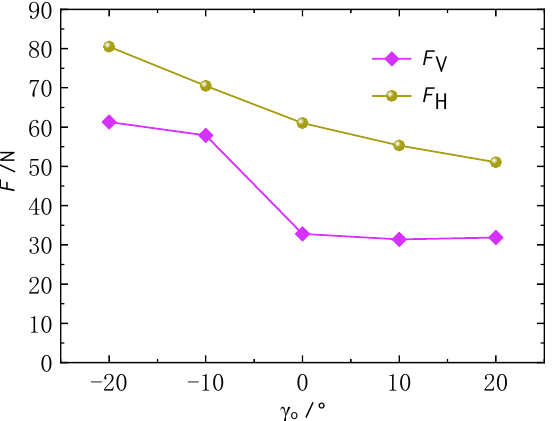
Figure 2. Cutting force at different rake angles.